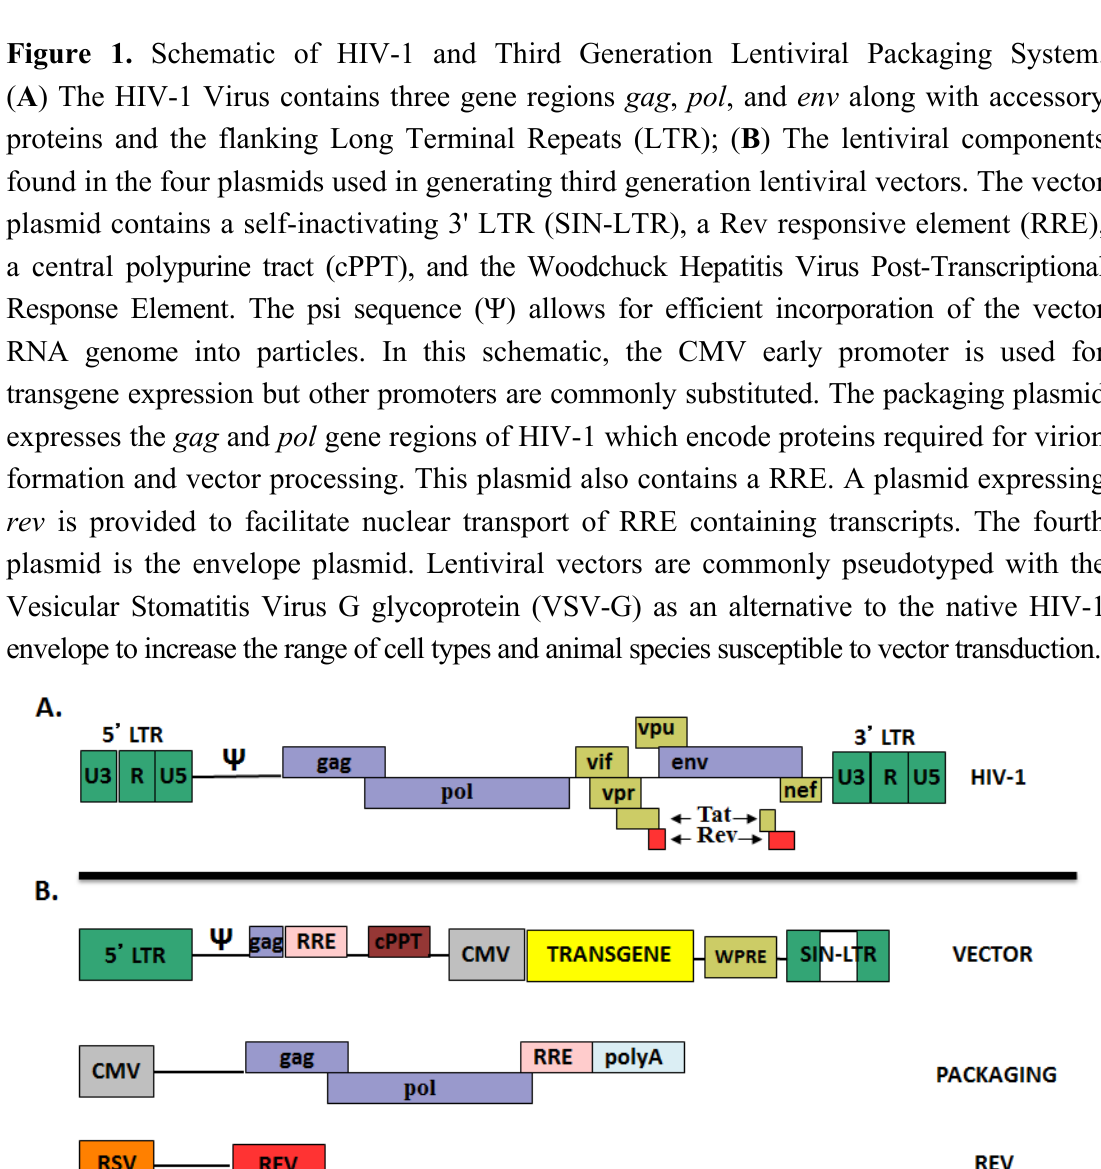
Figure 1. Schematic of HIV-1 and Third Generation Lentiviral Packaging